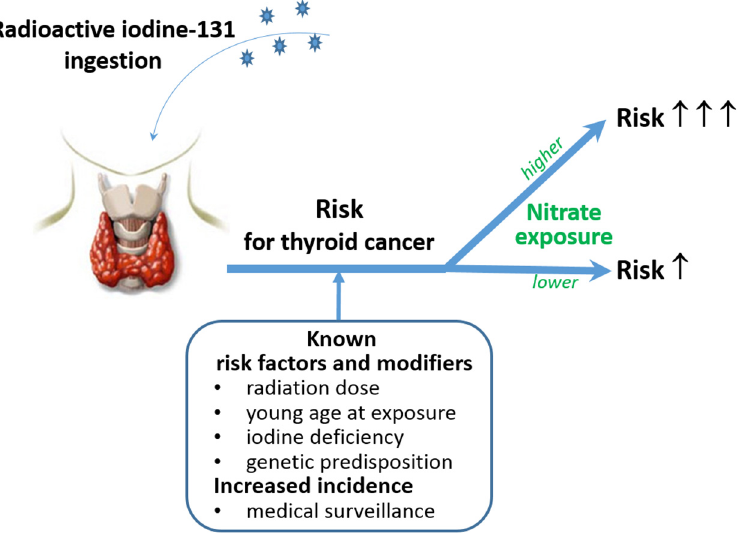
Fig 4. Recapitulation of the combination effect of radiation and nitrates on thyroid cancer risk. Exposure to both radiation and high levels of nitrates is proposed to increase risk for developing thyroid